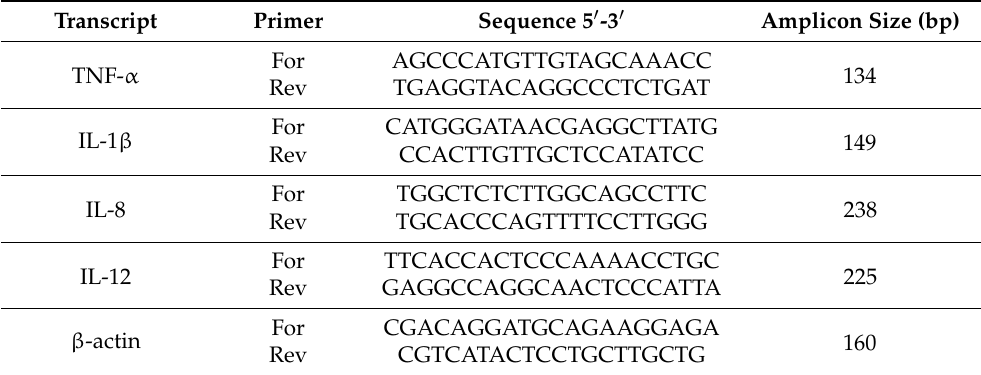
Table 1. Primer sequences used for quantitative Real-time PCR